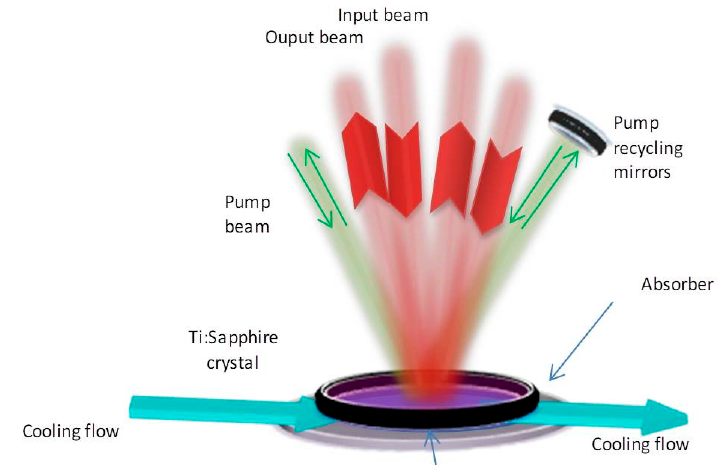
Figure 2. Layout of a single amplifying element in the reflection geometry. Table 2. Main design and operational parameter for the amplifier AMP3 in the reflection configuration.